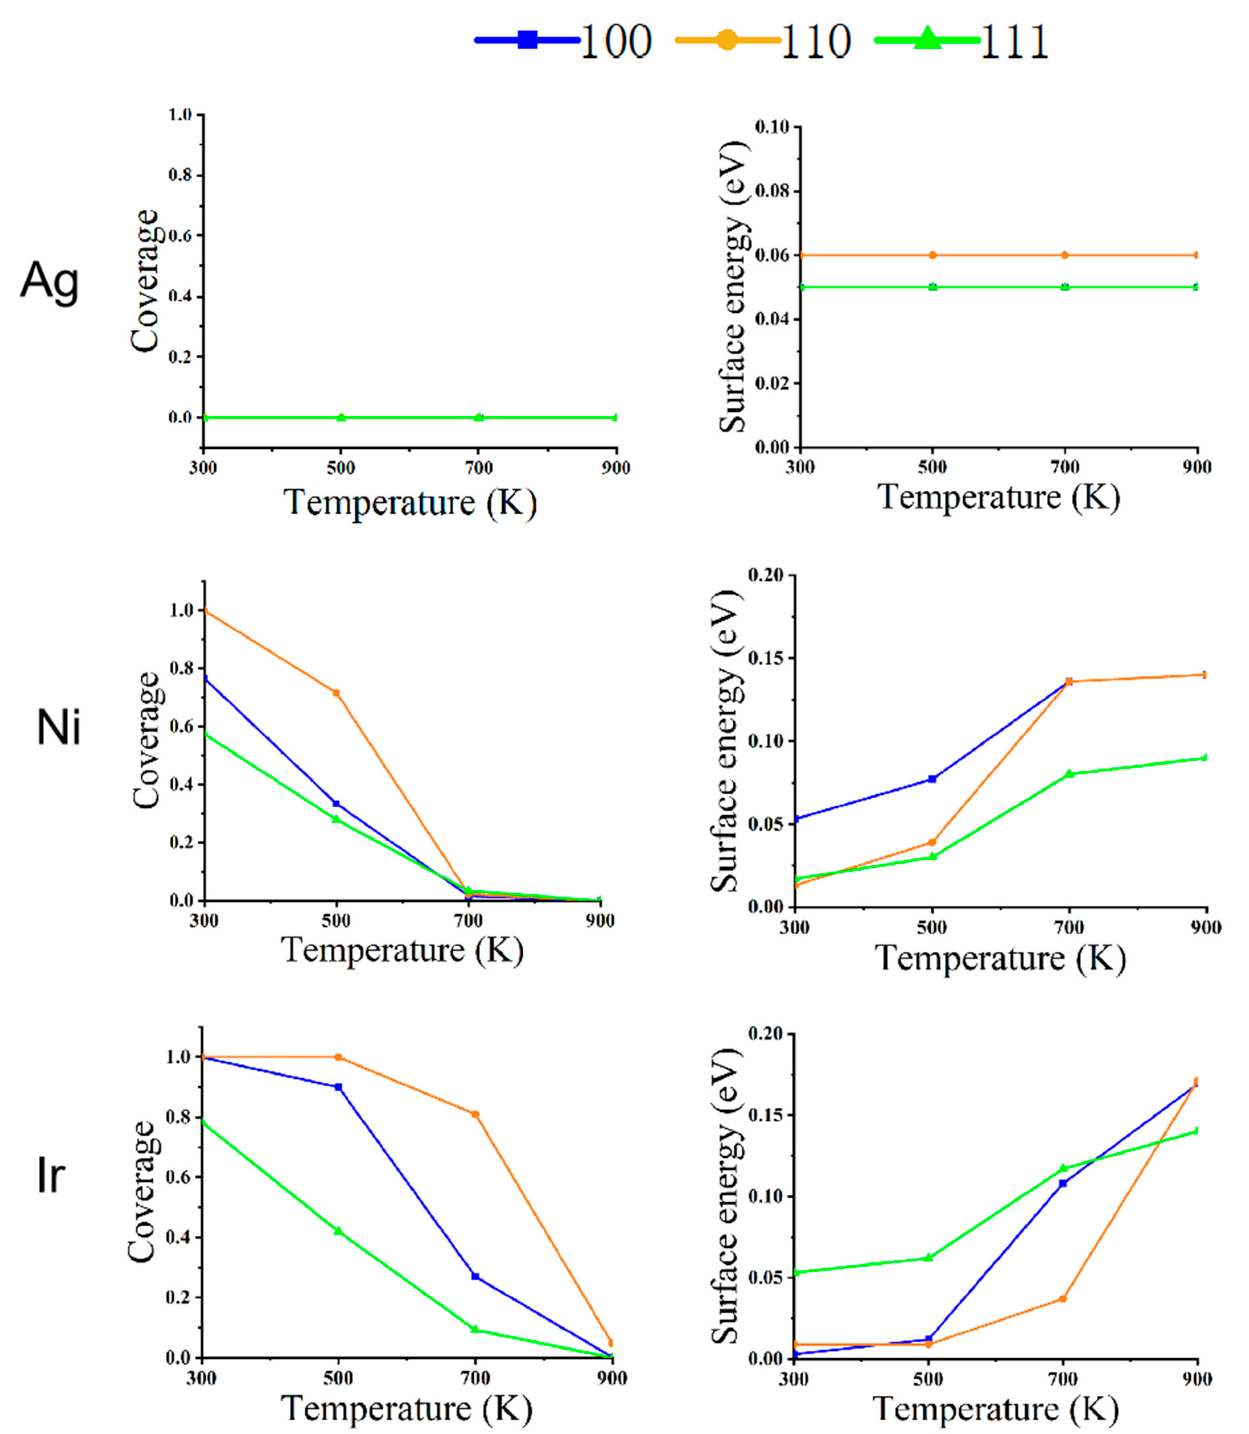
Figure 5. The relationship between CO coverage ( left ) and surface energy ( right ) in different faces of metal NPs (Ag, Ni, and Ir) at changing temperatures and a pressure of 100 Pa.